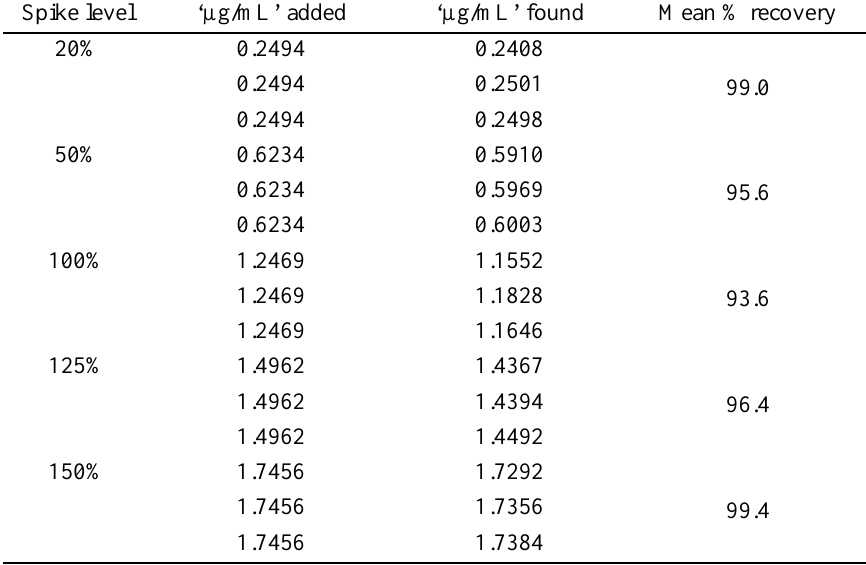
Table 2. Accuracy of lenalidomide